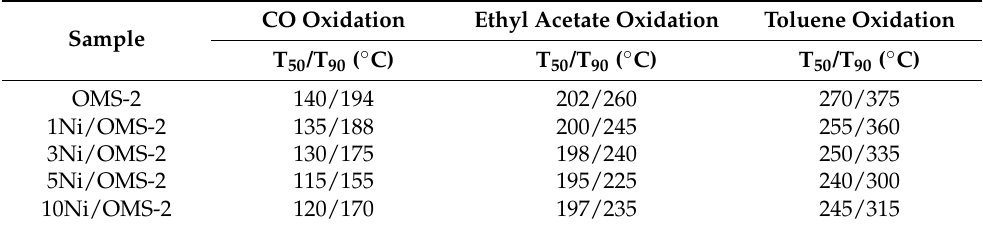
Table 3. Catalytic activities ( T 50 and T 90 ) of the OMS-2 and x Ni/OMS-2 samples for the oxi- dation of CO at SV = 60,000 mL/(g · h), ethyl acetate at SV = 240,000 mL/(g · h), and toluene at SV = 240,000 mL/(g · h).